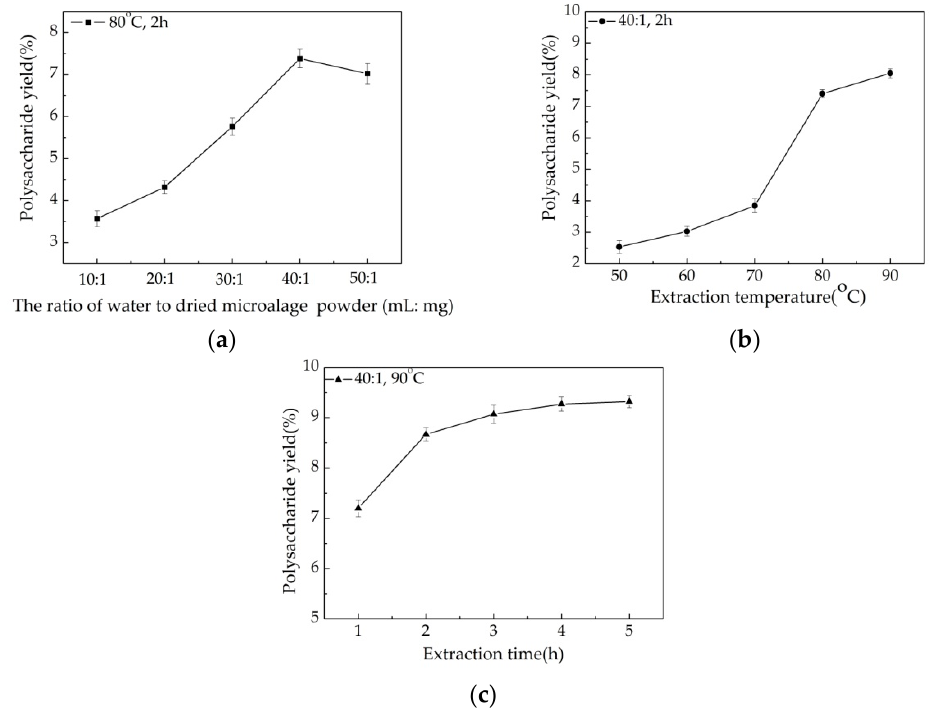
Figure 1. Effects of the ratio of water to dried algae powder ( a ) extraction temperature ( b ) and extraction time ( c ) on crude Chlorella -Arc polysaccharide extraction yield. Errors bars represent standard error for three replicates.